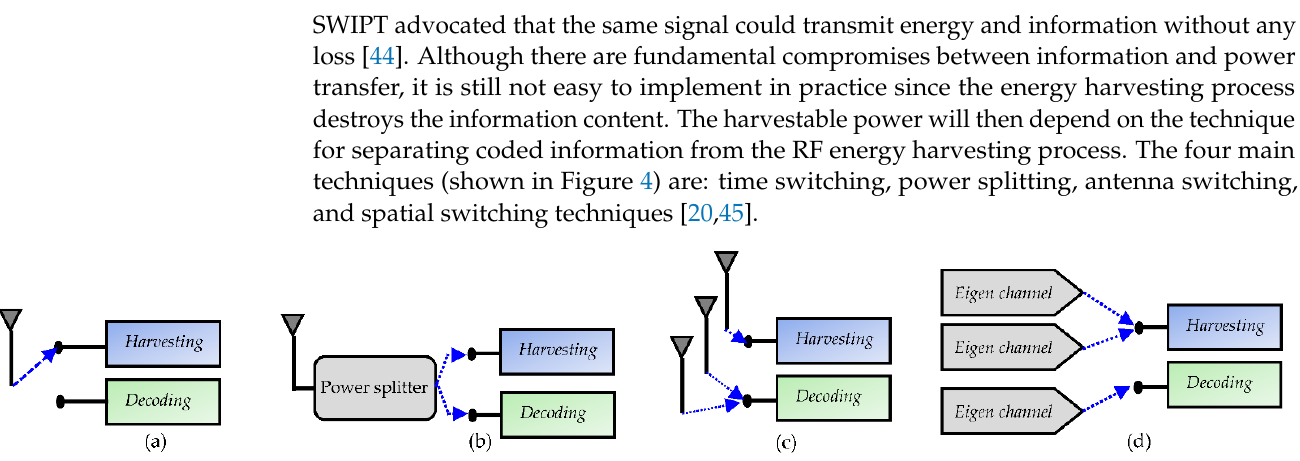
Figure 4. SWIPT transmission techniques in different domains: ( a ) Time. ( b ) Power. ( c ) Antenna. ( d ) Space.